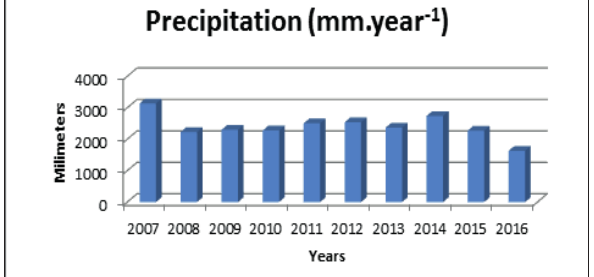
Figure 3. Annual rainfall distribution from 2007 to 2016 in Santo Tomas, Yurimaguas.